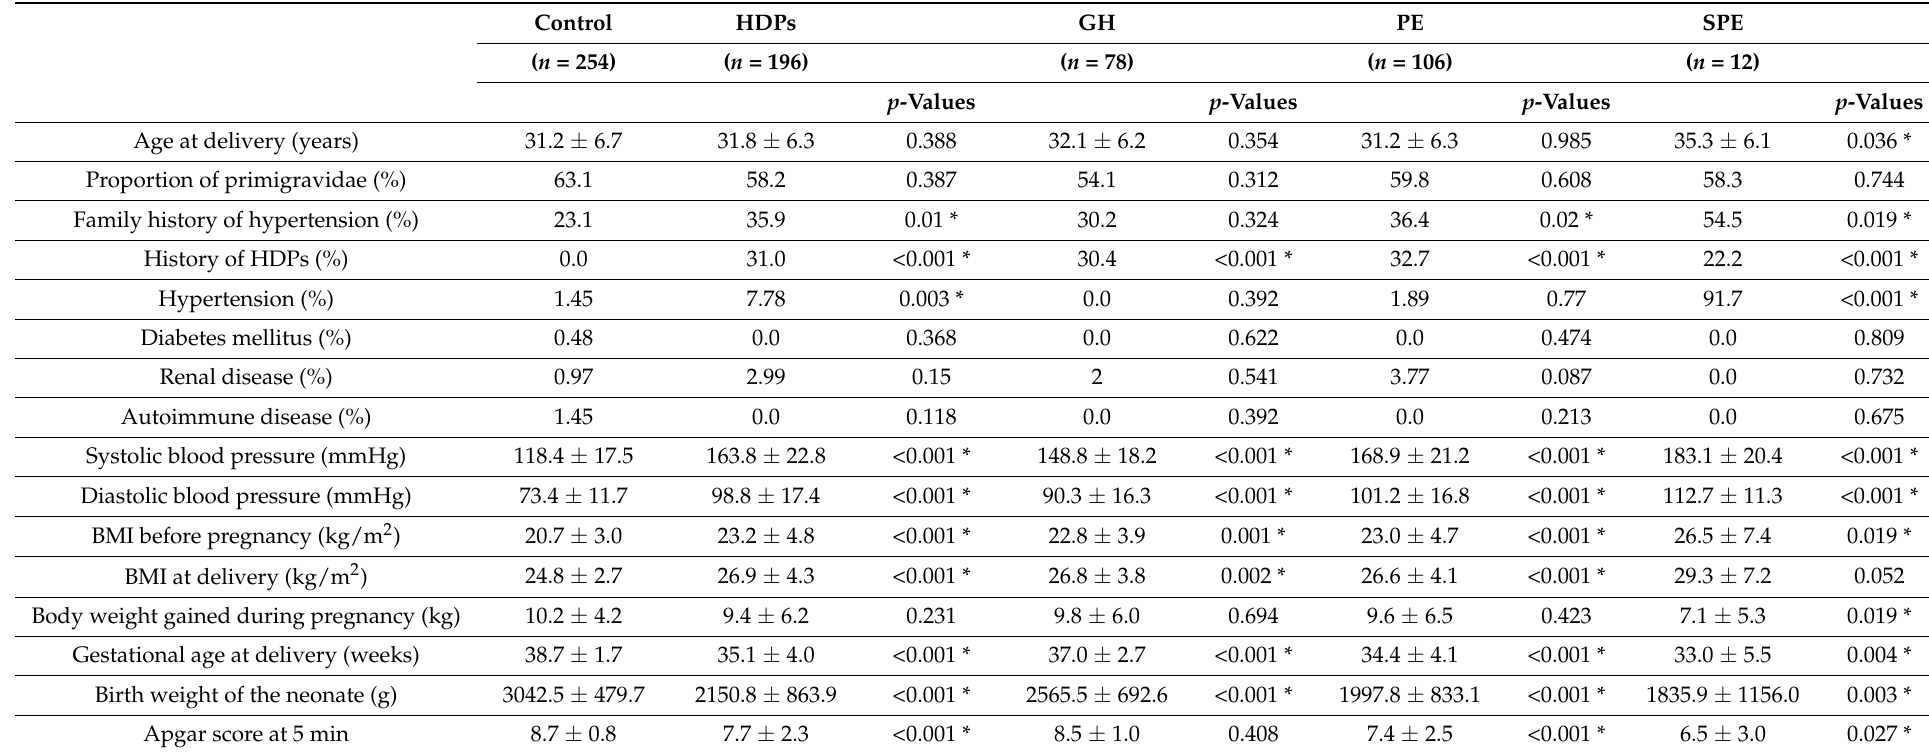
Table 2. Characteristics of the study